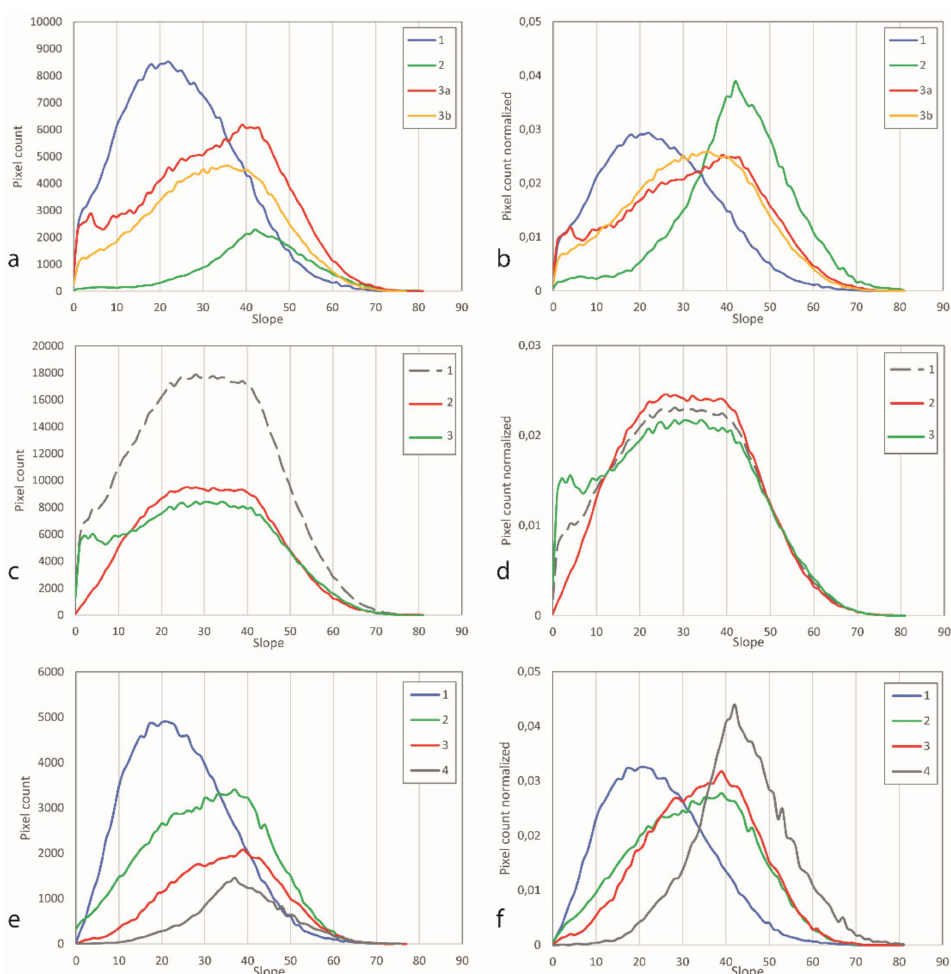
Figure 6. Trends of the slope variable ( a ) in the sectors subdividing the study area: Pesaro–Punta degli Schiavi (1), Punta degli Schiavi–Mt. Brisighella (2), Mt. Brisighella–Castel di Mezzo (3a), and Castel di Mezzo–Vallugola (3b); ( b ) in the sectors subdividing the study area considering normalized values: Pesaro–Punta degli Schiavi (1), Punta degli Schiavi–Mt. Brisighella (2), Mt. Brisighella–Castel di Mezzo (3a), and Castel di Mezzo–Vallugola (3b); ( c ) in the total study area (1) in comparison with areas affected (2) or not affected (3) by landslides; ( d ) in the total study area (1) in comparison with areas affected (2) or not affected (3) by landslides considering normalized values; ( e ) for each landslide typology occurring in the study area: slides (1), slumps (2), flows (3), and diffuse instability (4); ( f ) for each landslide typology occurring in the study area considering normalized values: slides (1), slumps (2), flows (3), and diffuse instability